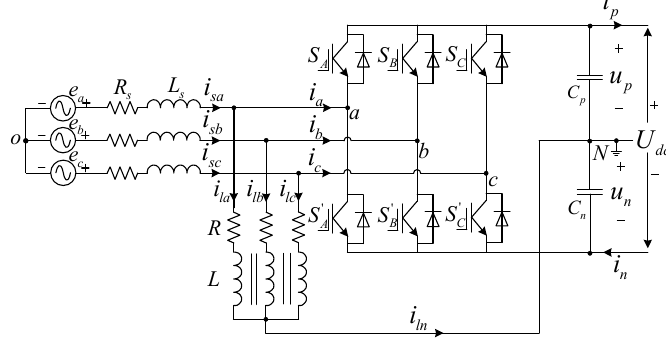
Figure 1. Topology diagram of the TCIBAR.